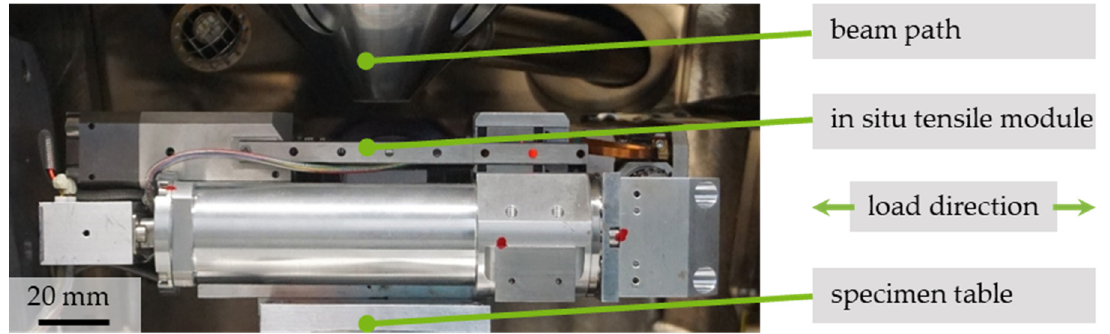
Figure 2. Mounted in situ tensile testing device for SEM.